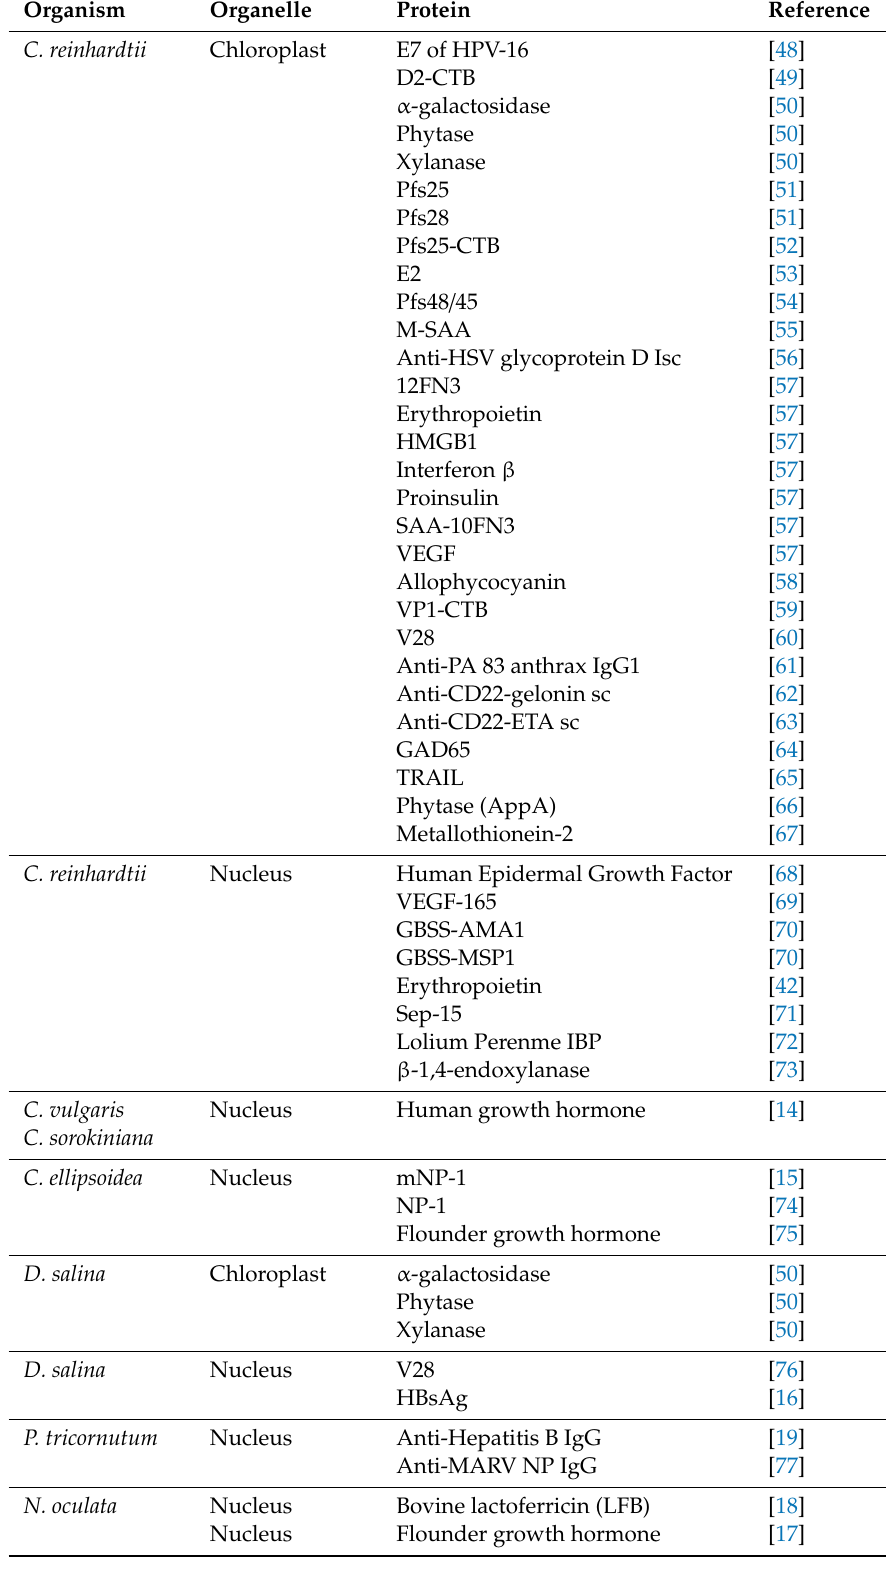
Table 1. Twenty years of recombinant biopharmaceutical production in